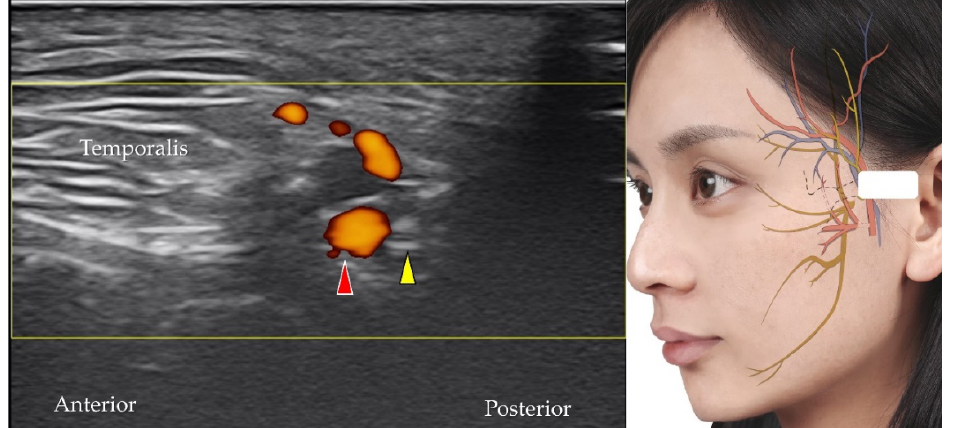
Figure 16. Power Doppler ultrasound imaging of the main trunk of the superficial temporal artery (red arrowhead) and the auriculotemporal nerve (yellow arrowhead) . White square , footprint of the ultrasound transducer.